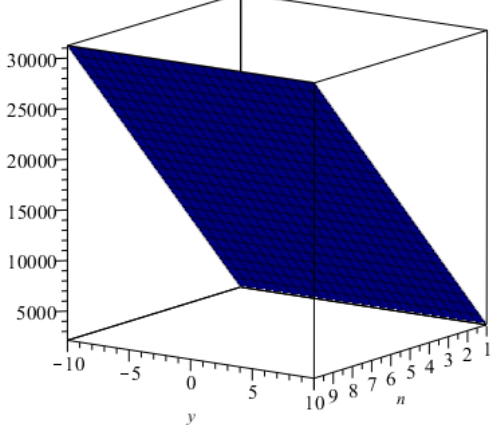
Figure 4. The graphical representation of the forgotten topological index.